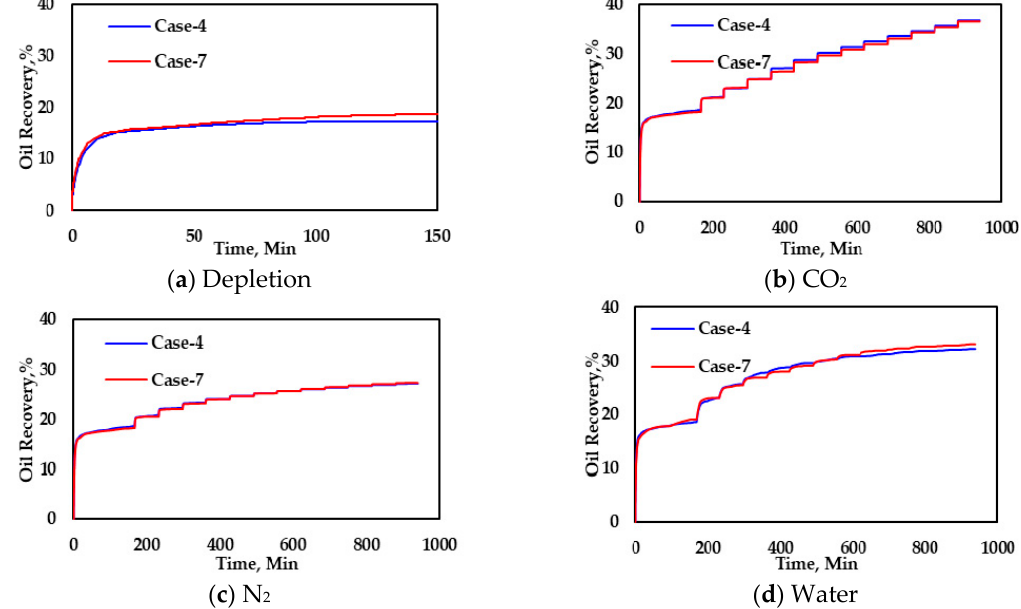
Figure 24. Oil recovery comparison with gravity effect.